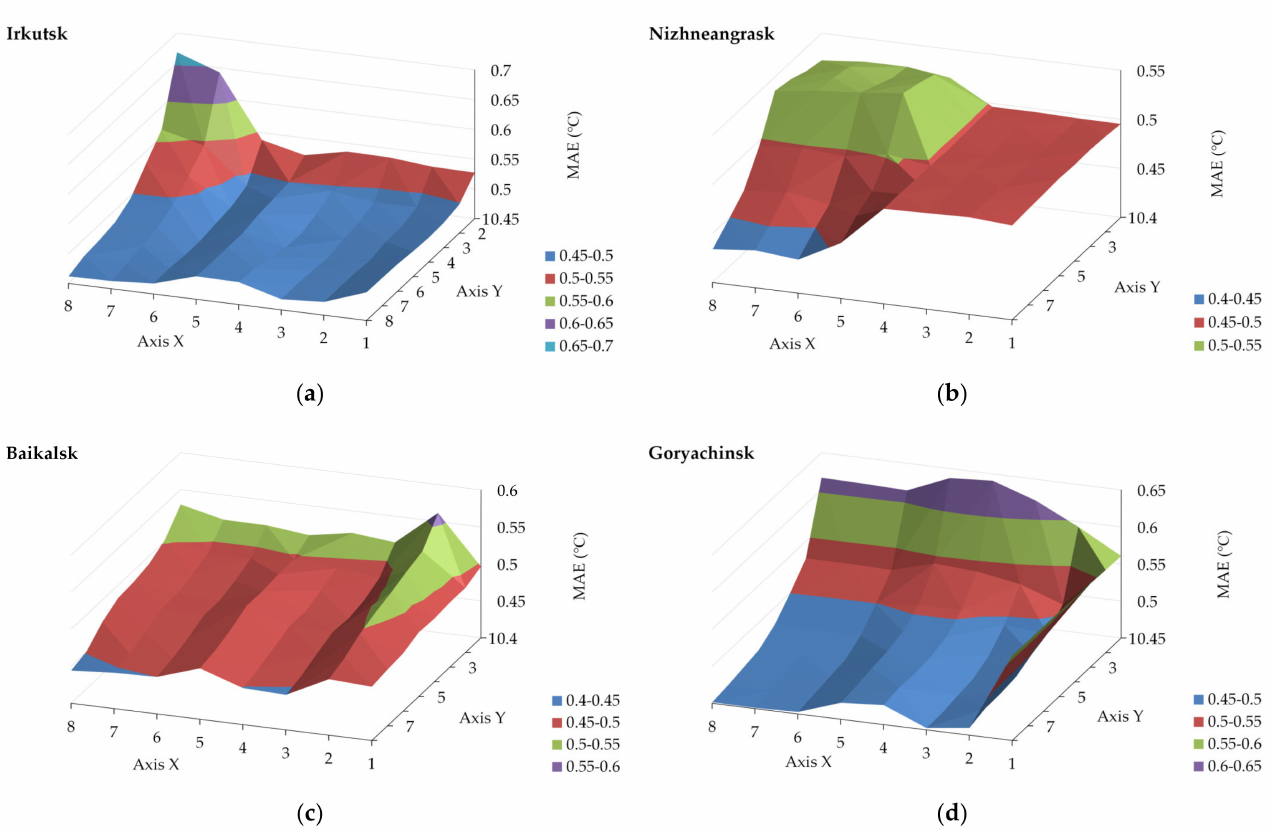
Figure 10. Dependence of MAE on the size of X used at the first ( x -axis) and second ( y -axis) stages of the proposed technique for predicting the air temperature with respect to Irkutsk ( a ), Nizhneangarsk ( b ), Baikalsk ( c ), Goryachinsk ( d